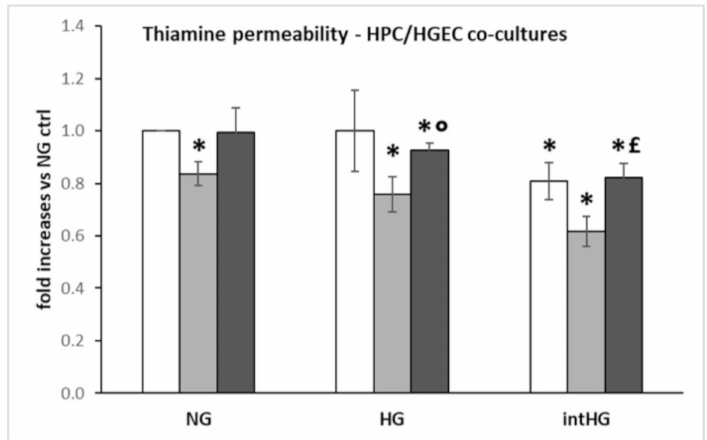
Figure 7. Thiamine permeability in HPC/HGEC cocultures. White bars: physiological thiamine concentrations (ctrl); light grey bars: thiamine-deficient medium (TD); dark grey bars: high thiamine concentrations (HT). NG = physiological glucose concentrations; HG = high glucose concentrations; intHG = intermittent high glucose concentrations. Mean of 5 experiments ± SD. * p < 0.05 vs. NG ctrl; ◦ p < 0.05 vs. HG TD; £ p < 0.05 vs. intHG